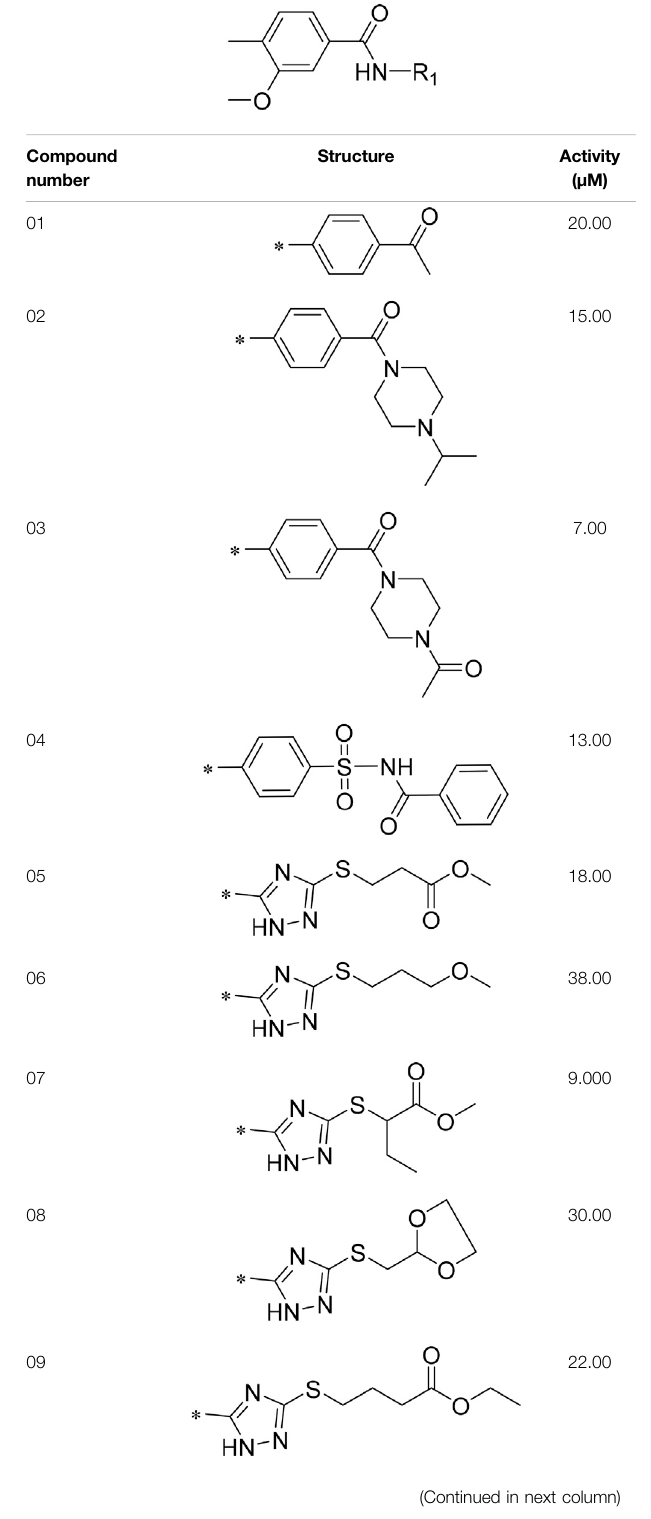
TABLE 1 | Structure of compounds 01 –